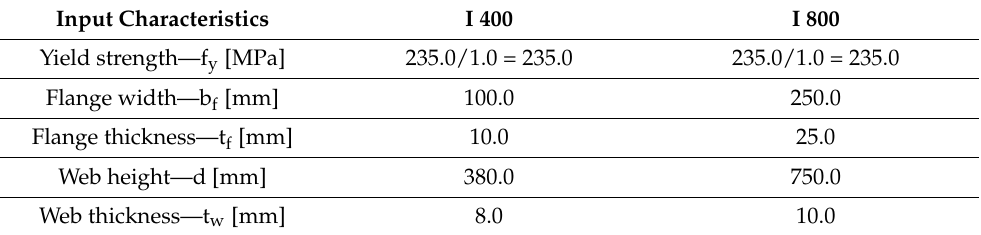
Figure 4. Model of typical steel plate girder bridge with bottom member members’ deck on railway line Žilina-Martin with girders I 400 and I 800 used in parametric study. Table 1. Cross-section characteristics of welded steel beams I 400 and I